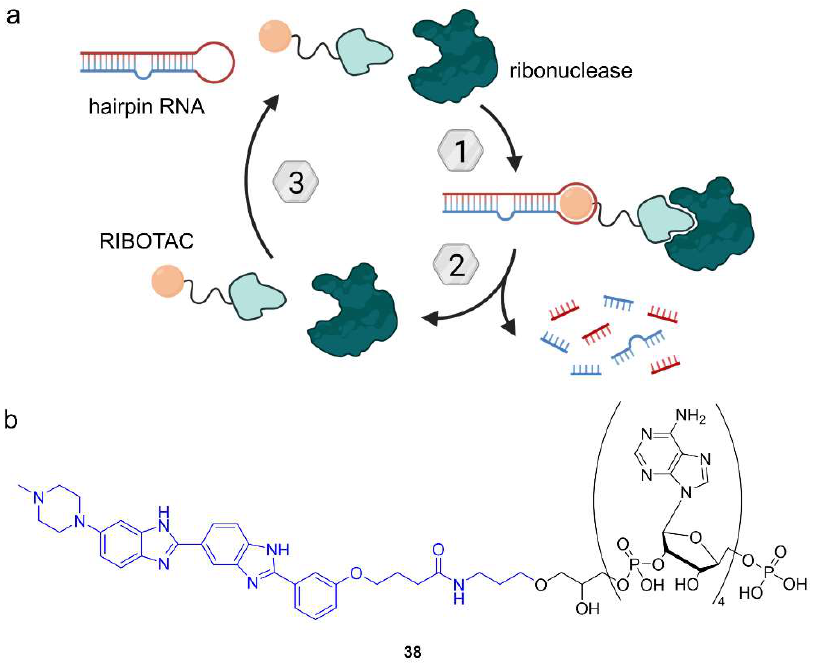
Figure 21. Ribonuclease-targeting chimeras (RIBOTACs) induce the ribonuclease-mediated degradation of RNA. ( a ) RIBOTACs comprise a small molecule binder of RNA and a 2′-5′-linked oligoadenylate tail as a recognition motif for ribonuclease. Formation of a ternary complex facilitates the proximity of RNA and ribonuclease, leading to RNA degradation. ( b ) Chemical structure of RIBOTAC 38 targeting pre-miR-210 using Targapremir-210 (blue).